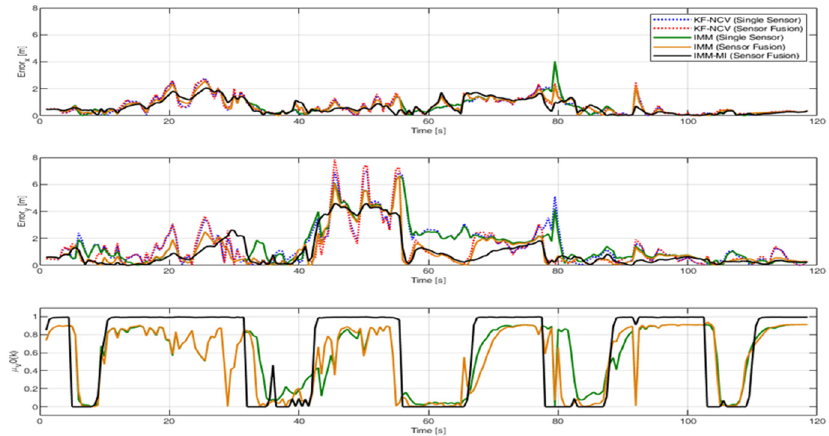
Figure 16. The positioning errors and V0 model probabilities of the experimental data for the drone localization and tracking.